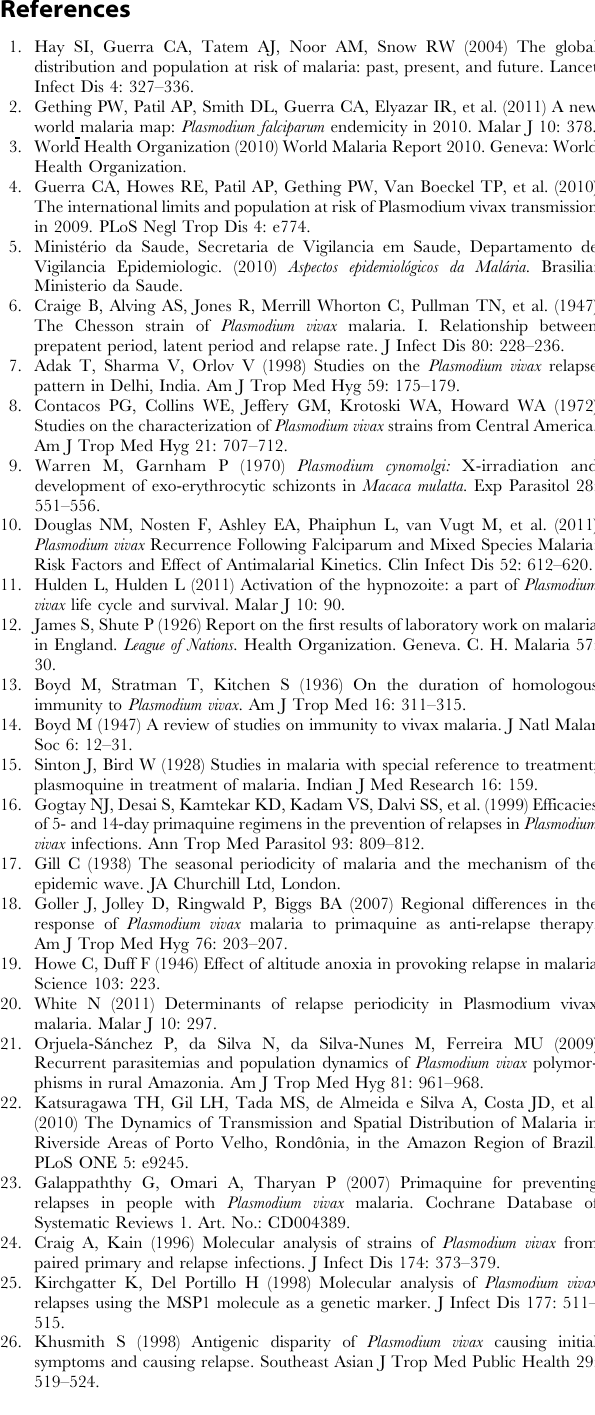
Table S2 Characteristics of predominant alleles from genotyping of 10 molecular markers of Plasmodium vivax infected